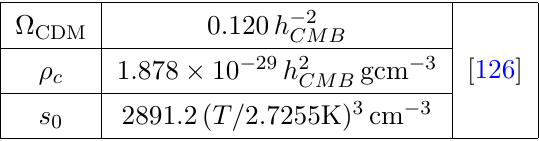
Table 4. Data about CDM ( h CMB ≈ 0 . 674